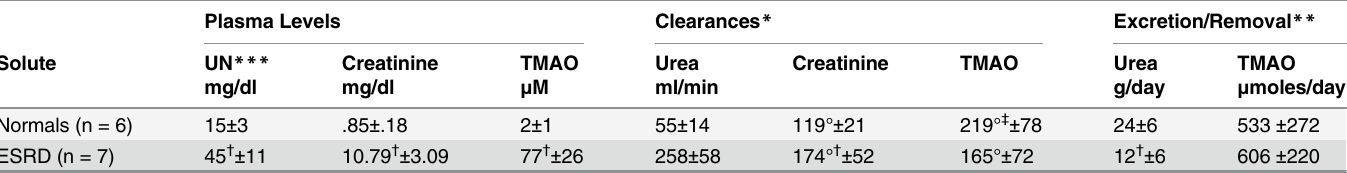
Table 1. Solute plasma levels, clearance rates, and excretion rates for study